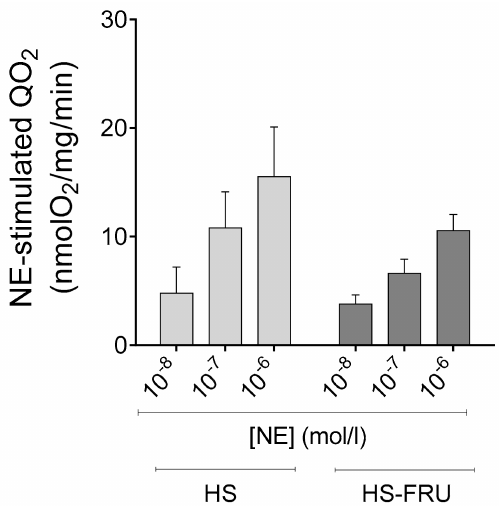
Figure 7. Effect of norepinephrine (NE) on oxygen consumption (QO 2 ) by proximal tubule suspensions from rats fed a high-salt diet drinking tap water (HS) or 20% fructose (HS-FRU). By two-way ANOVA: NE effect ( p < 0.03); fructose effect ( p = 0.96); interaction ( p =